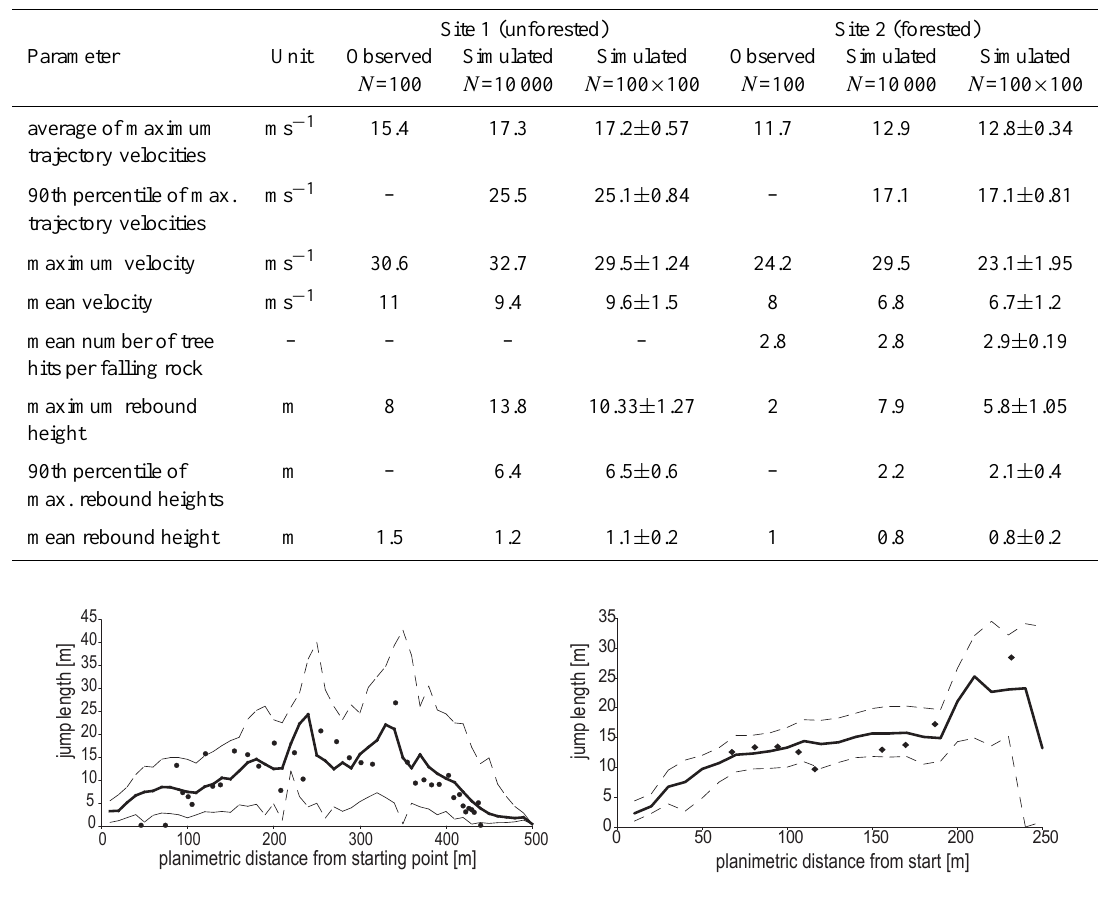
Table 3. Summary of observed and simulated (with improved rebound algorithm) rockfall parameters for both sites in Vaujany. The columns denoted with N = 100 × 100 present the mean and standard deviation of 100 simulation series with 100 rocks each.